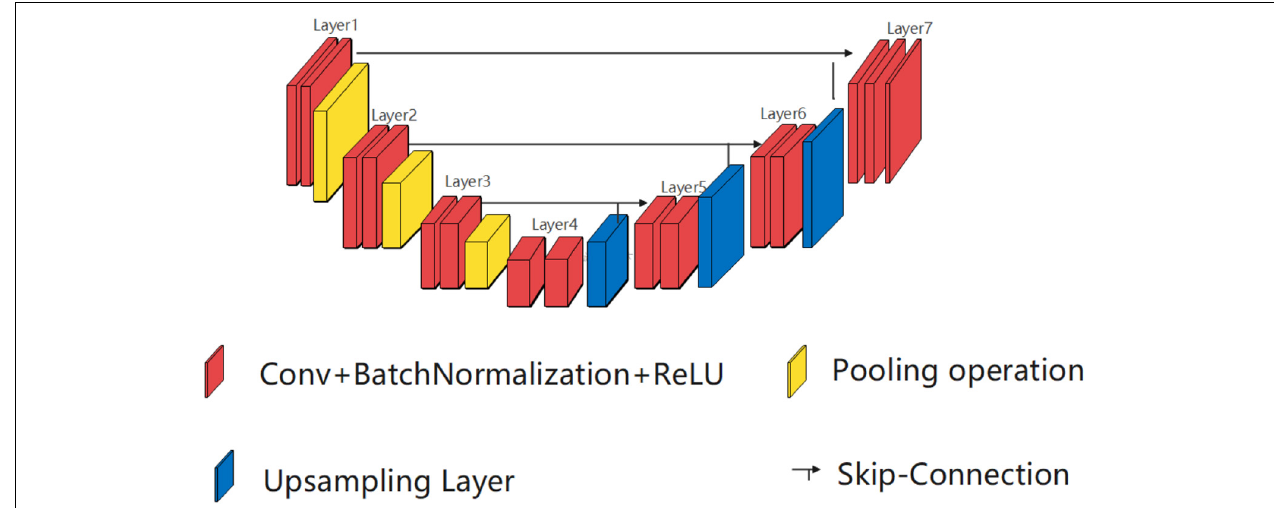
FIGURE 1 | Structure diagram of UNet.